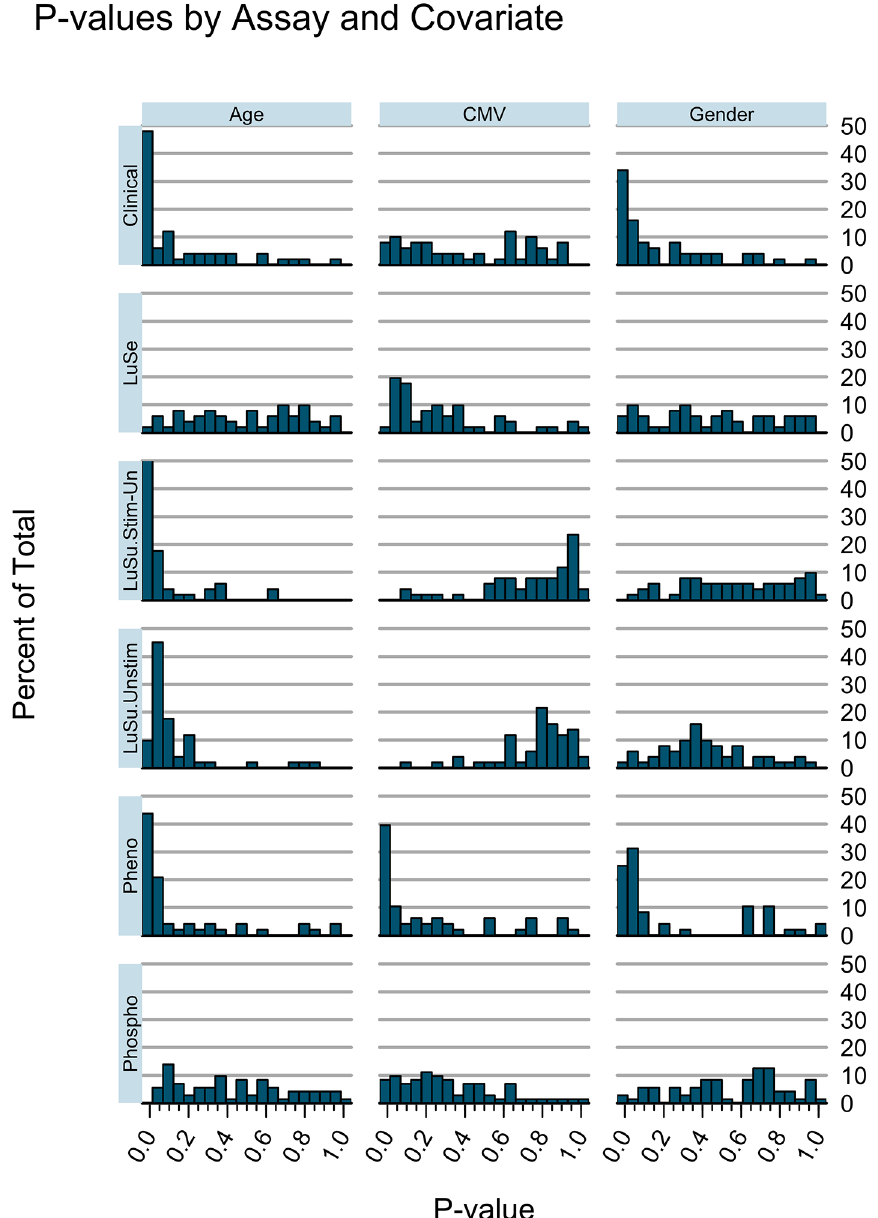
Fig 2. Overview of age, sex, and CMV-status associations with laboratory and clinical assay results. Histograms show the distribution of P values for the analytes within each assay category. Clinical = all